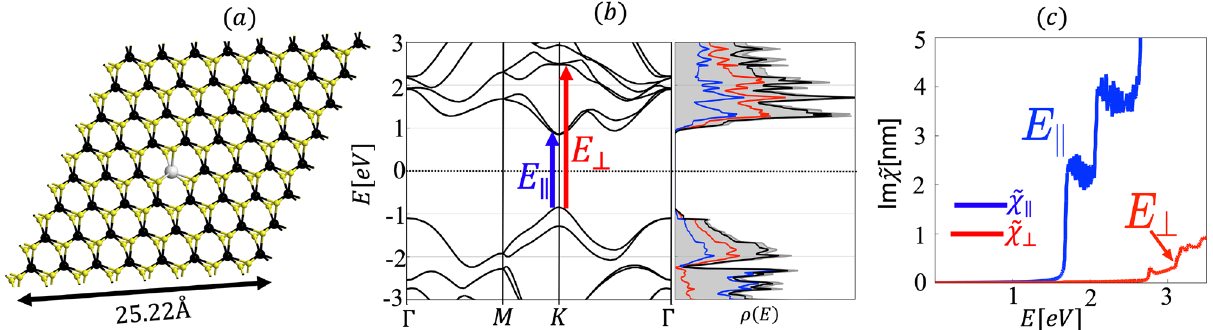
8 1 supercell of SL WS 2 . The grey circle depicts × × 1.6 eV and an out-of-plane band gap of E 3.2 � = ⊥ = 433 meV. Gray region in the DOS plot =